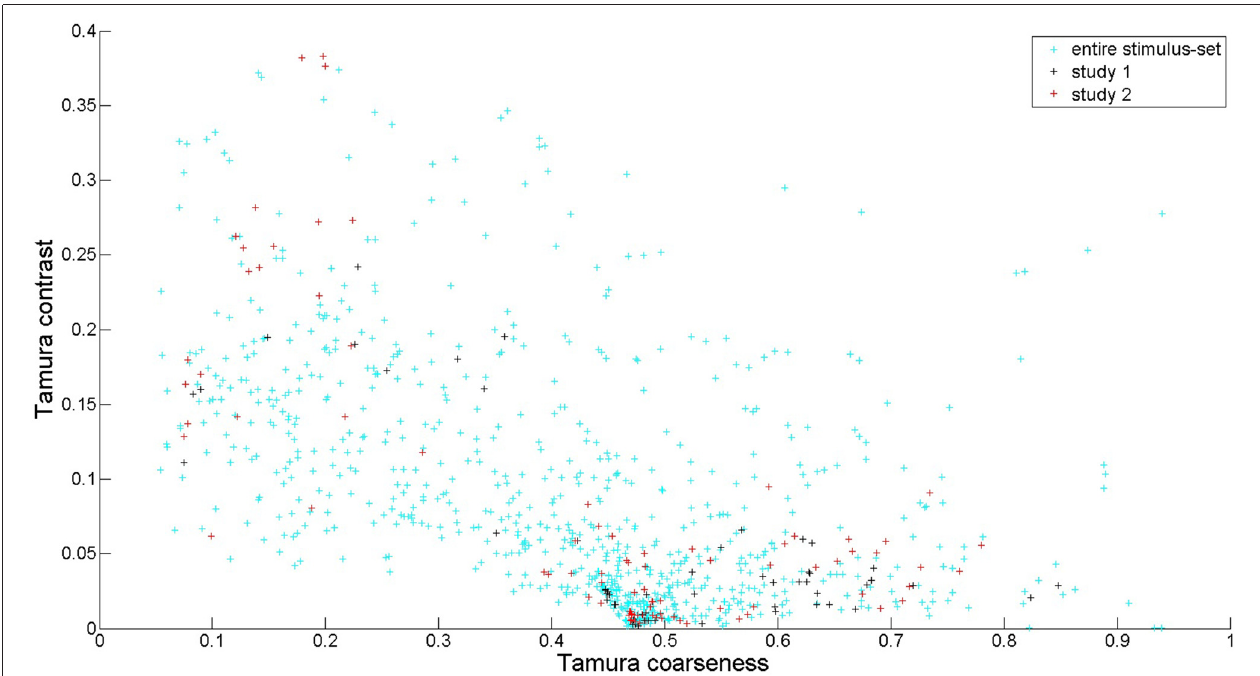
FIGURE 4 | Feature values of textures for Tamura coarseness and contrast. All textures in our database are depicted in cyan (light blue). The ones used in semantic differential experiment 1 are depicted in black, and the ones used in semantic differential experiment 2 are depicted in red. Tamura coarseness was already well covered in experiment 1. In experiment 2, some higher values for Tamura contrast were included to have a better coverage of this feature. We could not take into account all possible combinations of features, and in this case one can see that the combination of high Tamura coarseness and high Tamura contrast was not